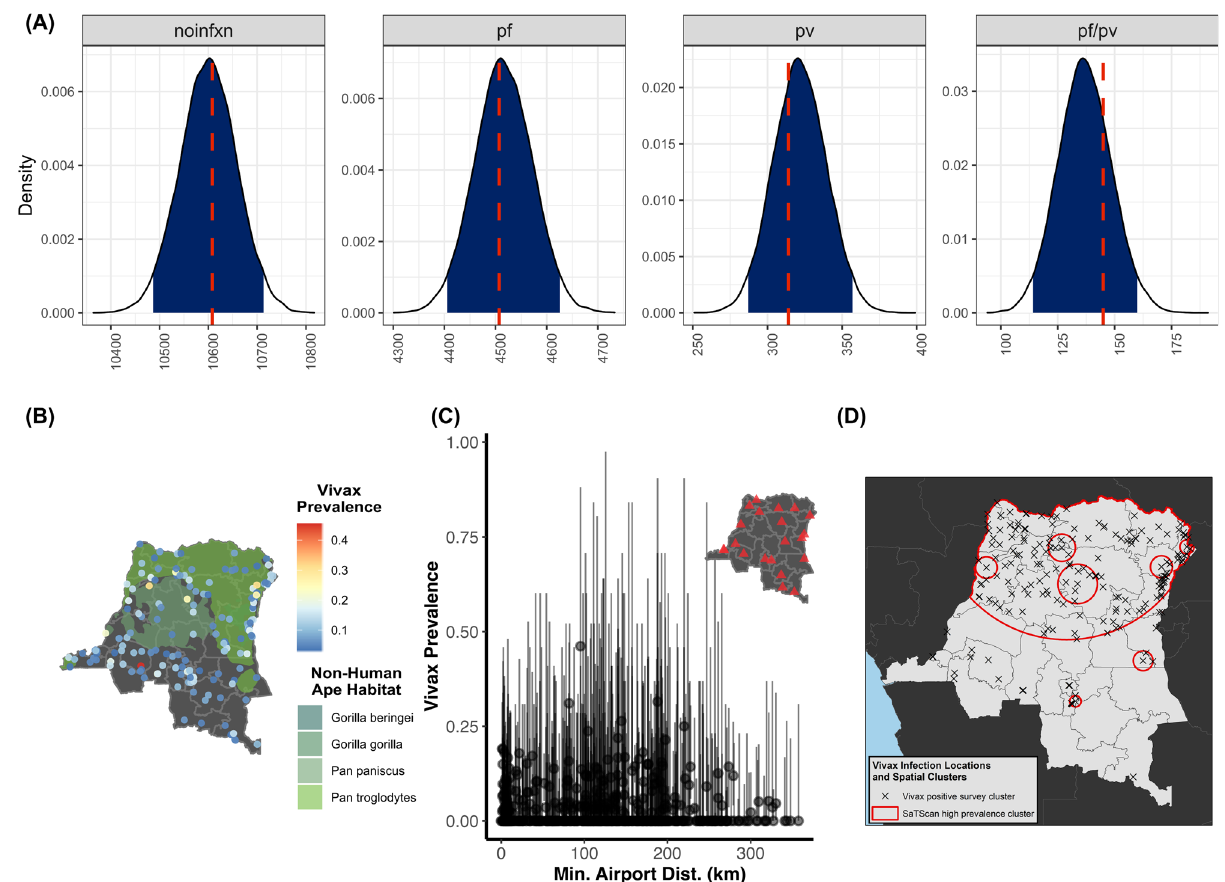
Fig. 3 Non-parametric risk factor analysis and spatial clustering of P. vivax Infections. A Composition of P. vivax and P. falciparum co-infections. The expected versus observed composition of P. vivax and P. falciparum infections were explored using a multinomial probability likelihood model testing for independent acquisition of each species. To incorporate DHS sample weights, infections were rounded to the nearest integer. The plot shows the expected distribution for individuals without infection ( “ noinfxn ” ), P. falciparum infections ( “ pf ” ), P. vivax infections ( “ pv ” ), and P. falciparum – P. vivax co-infections ( “ pf/pv ” ). The blue shading indicates the 95% bootstrapped interval and the red-dotted line indicates the observed number of cases for each infection category. Overall, the observed distribution of each infection composition was explained well by each species occurring independently, which suggests that there were no interspecies infection synergism or antagonism. B Overlap with non-human ape habitats and positive P. vivax clusters. Overall, P. vivax prevalence did not appear to be associated with non-human ape habitat distribution (prevalence displayed as a proportion). This lack of a P. vivax -non- human ape association was recapitulated with permutation testing. Clusters with P. vivax infections are shaded on a blue – red spectrum with respect to the cluster-level prevalence, with the distribution of each non-human ape habitat is indicated in shades of green. C Correlation of P. vivax cluster prevalence with airport distance. The point estimate and 95% con fi dence interval for each cluster is shown as a point-range. Standard errors for the con fi dence intervals were calculated with the binomial exact method: to incorporate DHS weights, we rounded to the nearest integer. Airport distance was used as a proxy for the potentiality of P. vivax fl ight importation risk, or “ airport malaria ” risk. Overall, there did not appear to be a correlation between this variable and P. vivax prevalence (energy-correlation: 0.07). D Cluster detection of P. vivax infections. P. vivax infections appeared to be clustered in the northern and northeastern regions of the DRC with a small cluster also indicated in the center of the